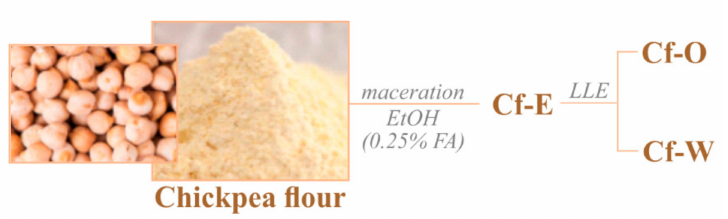
Figure 1. Extraction and fractionation scheme applied to chickpeas before UHPLC-HRMS analysis (FA = formic acid; LLE = liquid/liquid